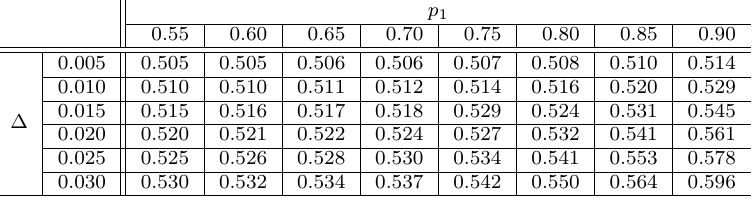
for different PUF biases p 1 and resolutions 1